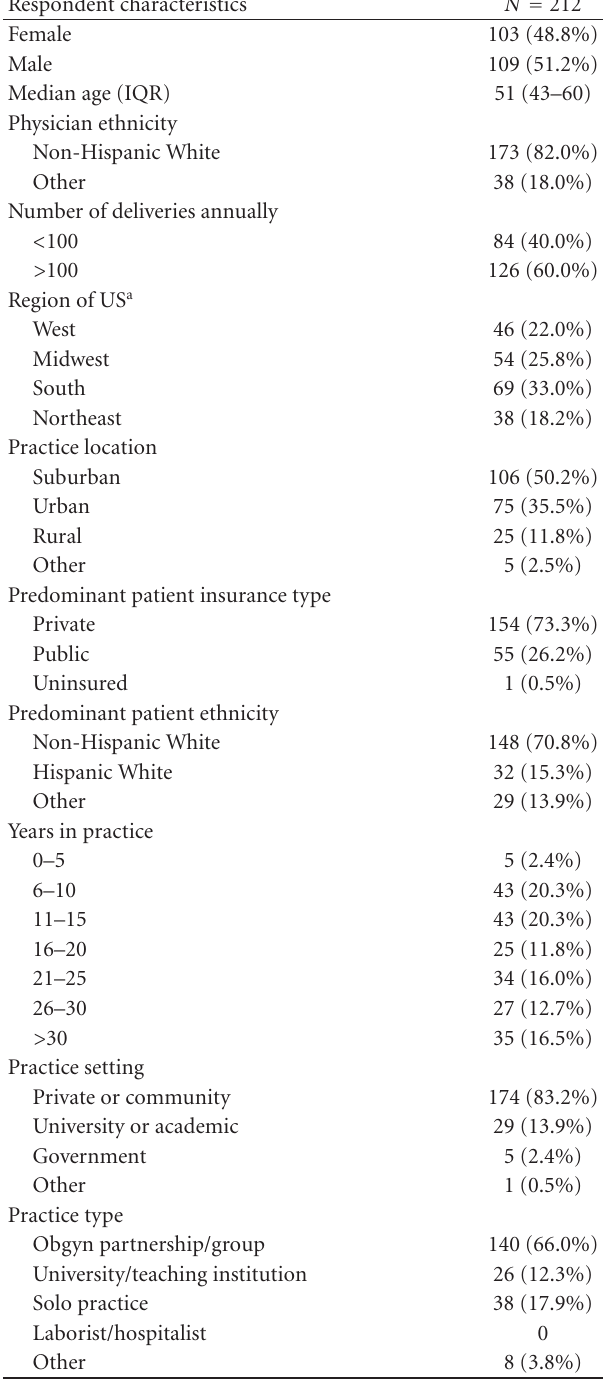
Table 2: Respondent